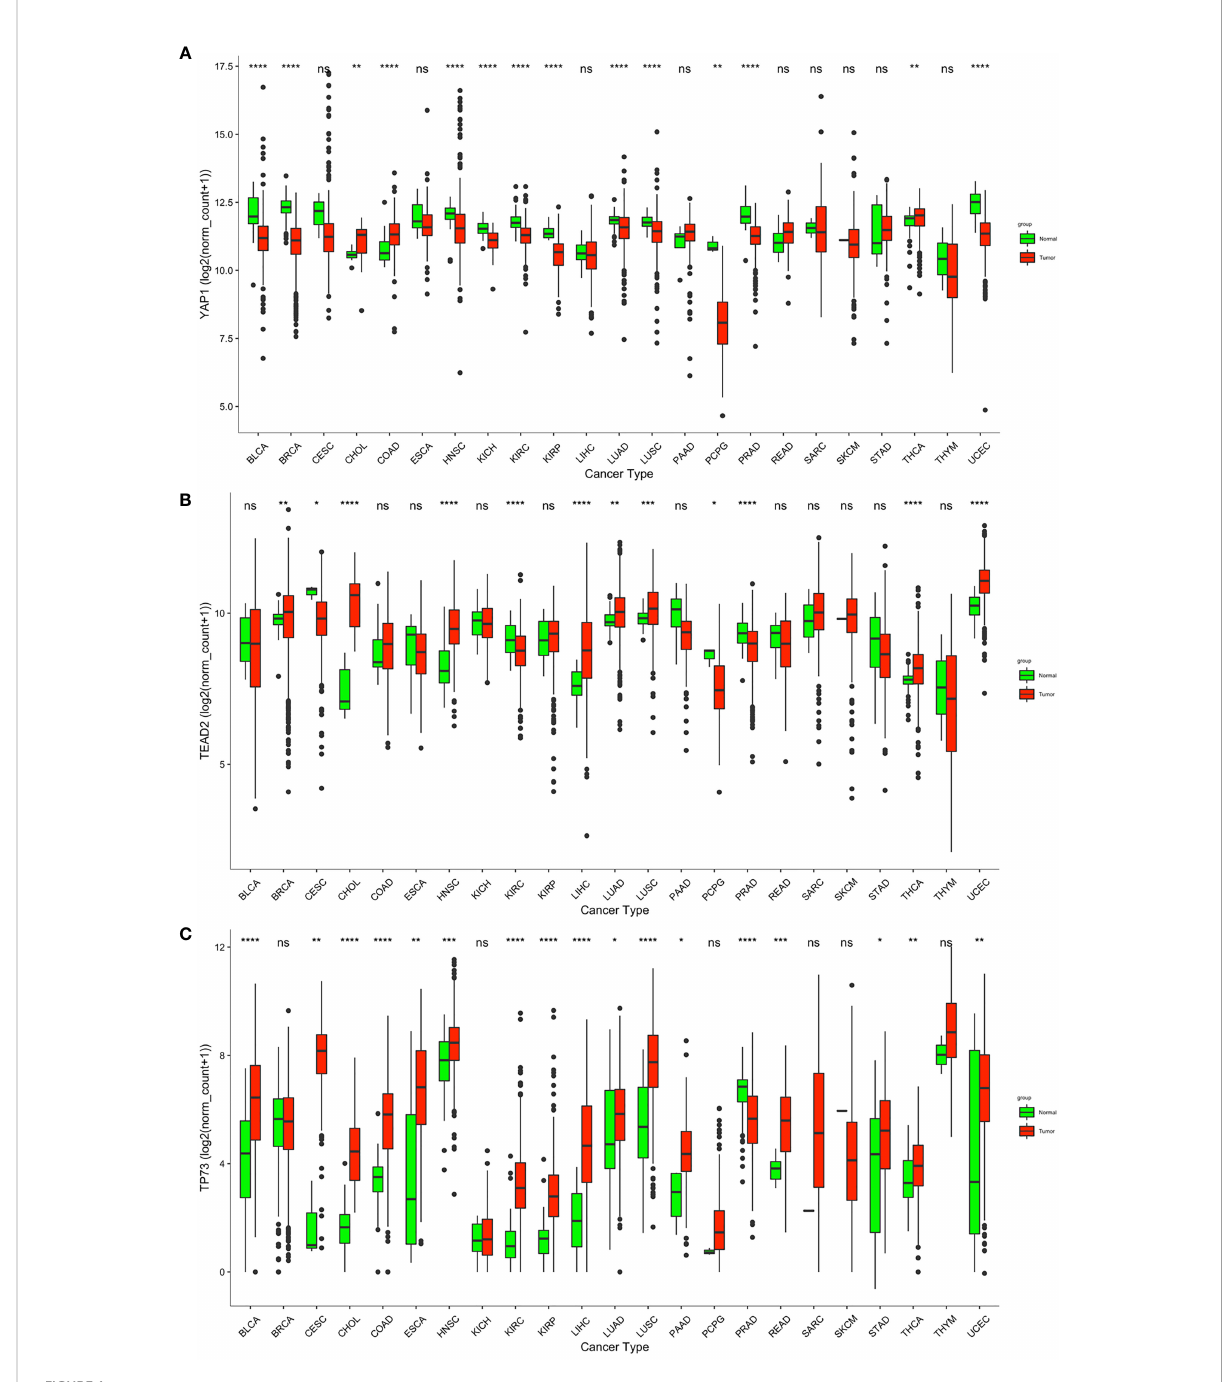
FIGURE 1 Transcriptional level of YAP1, TEAD2, and TP53 in normal and cancer tissues according to RNA-sequence data from TCGA. ****p < 0.0001, ***p < 0.001, **p < 0.01, *p < 0.05, and ns p >